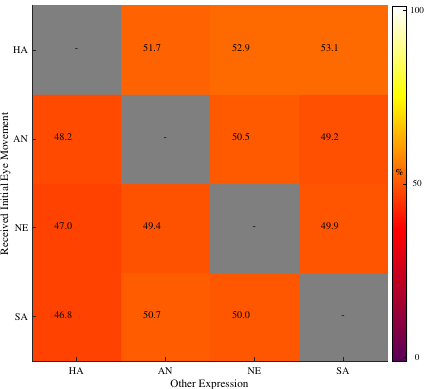
Figure 4. The average percentage of initial eye movements, across participants, towards a particular expression (y-axis; HA happy, AN angry, NE neutral and SA sad) separately depending on the expression in the other image (x-axis). Note that this is for trials in which two different expressions were displayed. Results show a small but significant bias towards happy expressions. Figure generated using Matlab 2019b ( www. mathw orks.